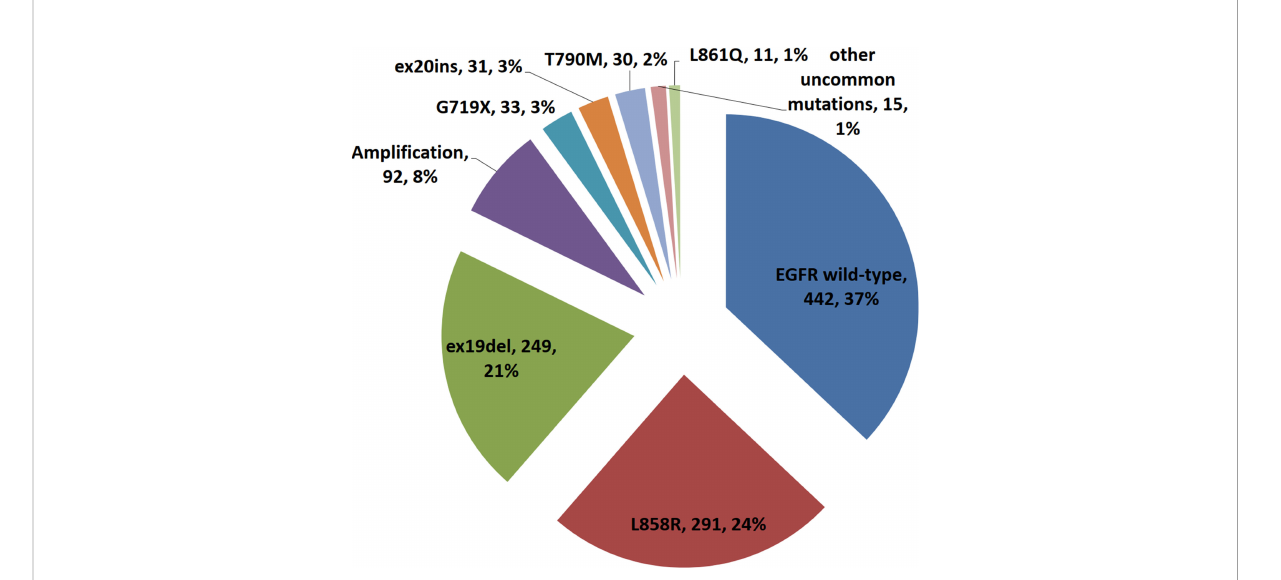
FIGURE 1 The proportion of patients with different subtypes of EGFR mutations in the 1,111